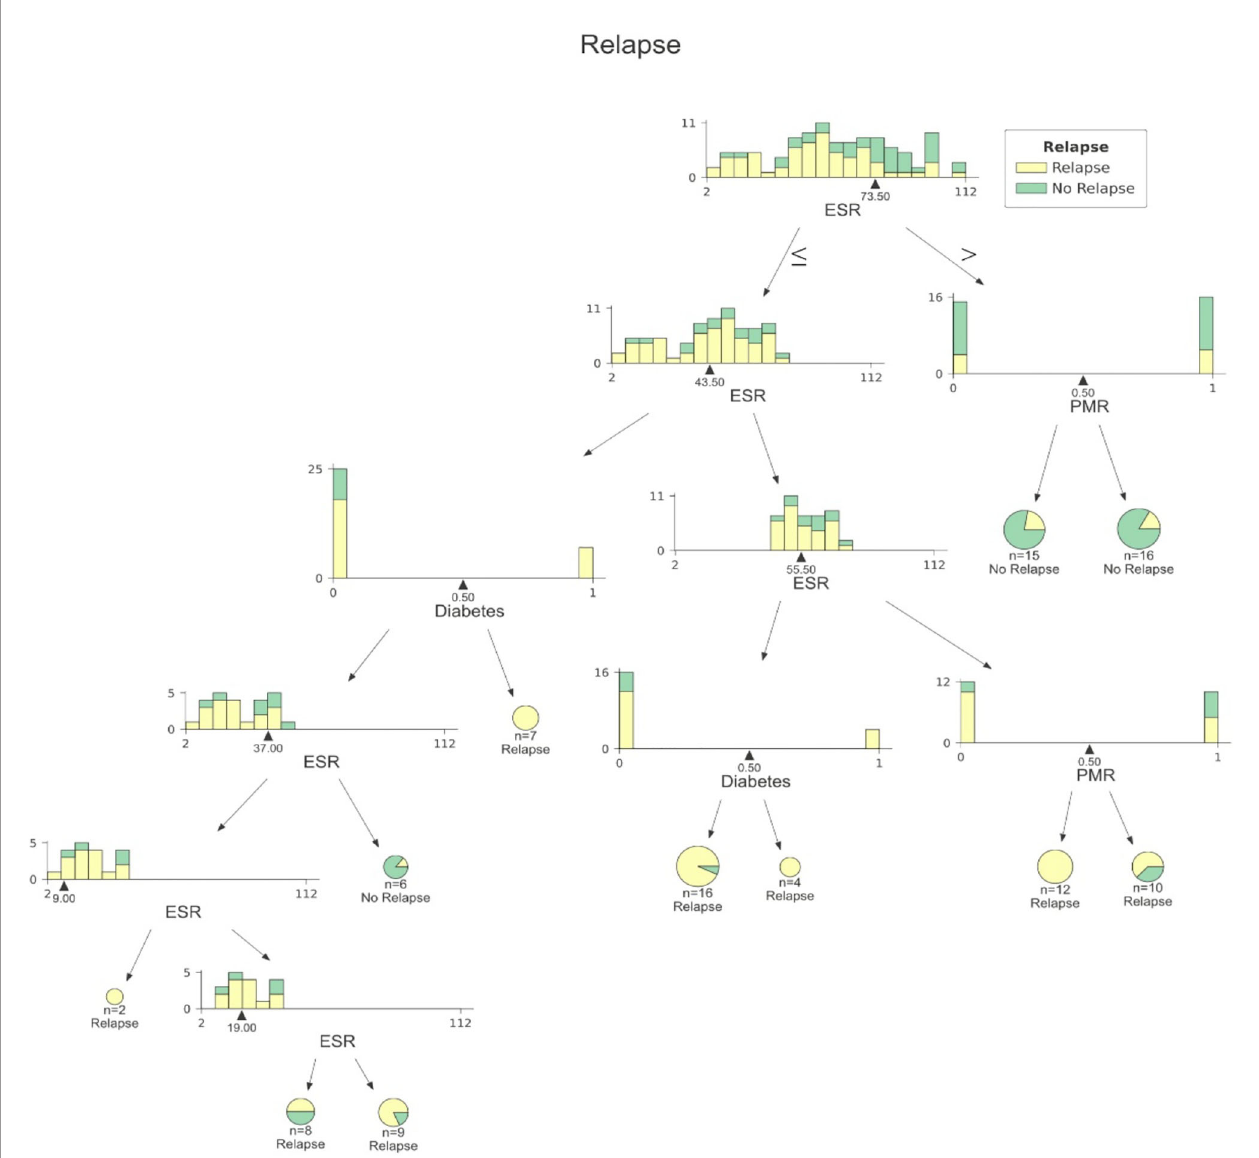
FIGURE 3 | A sample decision tree among those included into RF. At each node data are split according to ESR, presence/absence DM or presence/absence of PMR. DM, Diabetes mellitus; ESR, Erythrocyte Sedimentation Rate; PMR, Polymyalgia